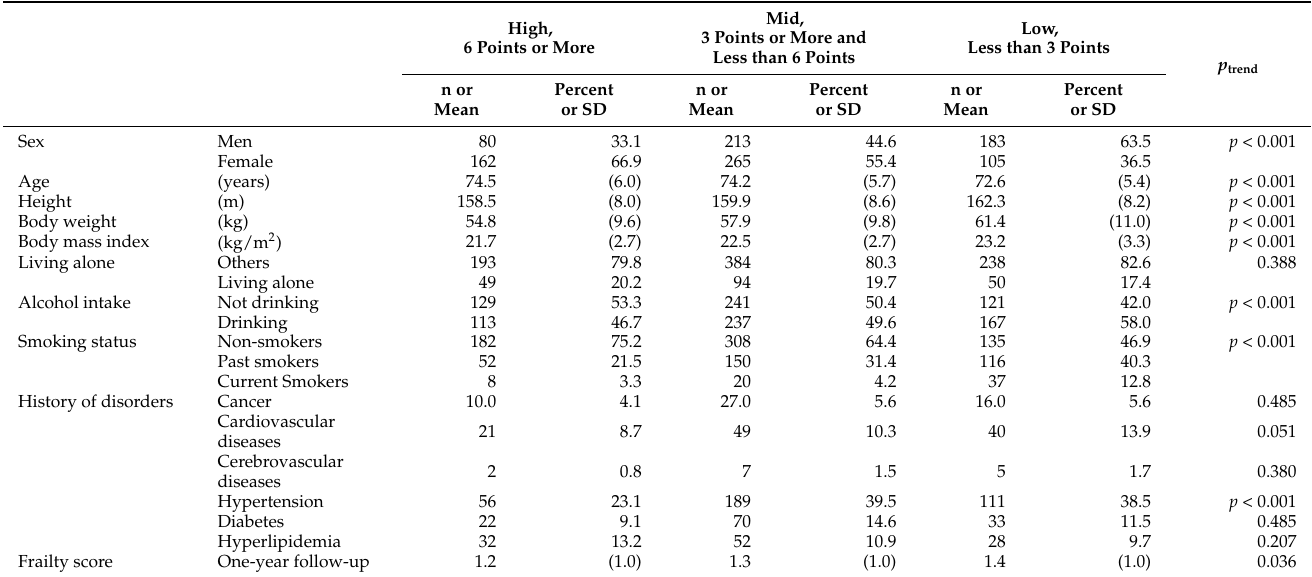
Table 4. Subject characteristics based on food variety